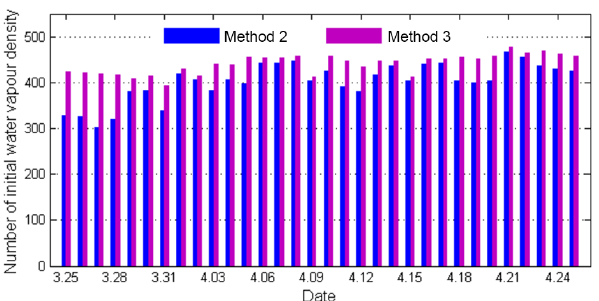
Figure 7. External accuracy of the unit scale factor models used for methods 2 and 3 in the experiment.